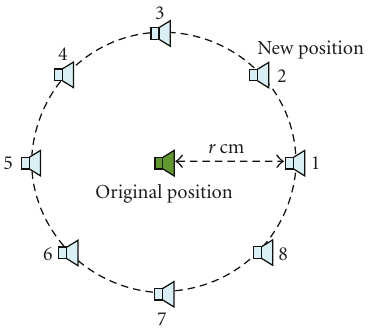
Figure 10: Source positions considered in the experiment.